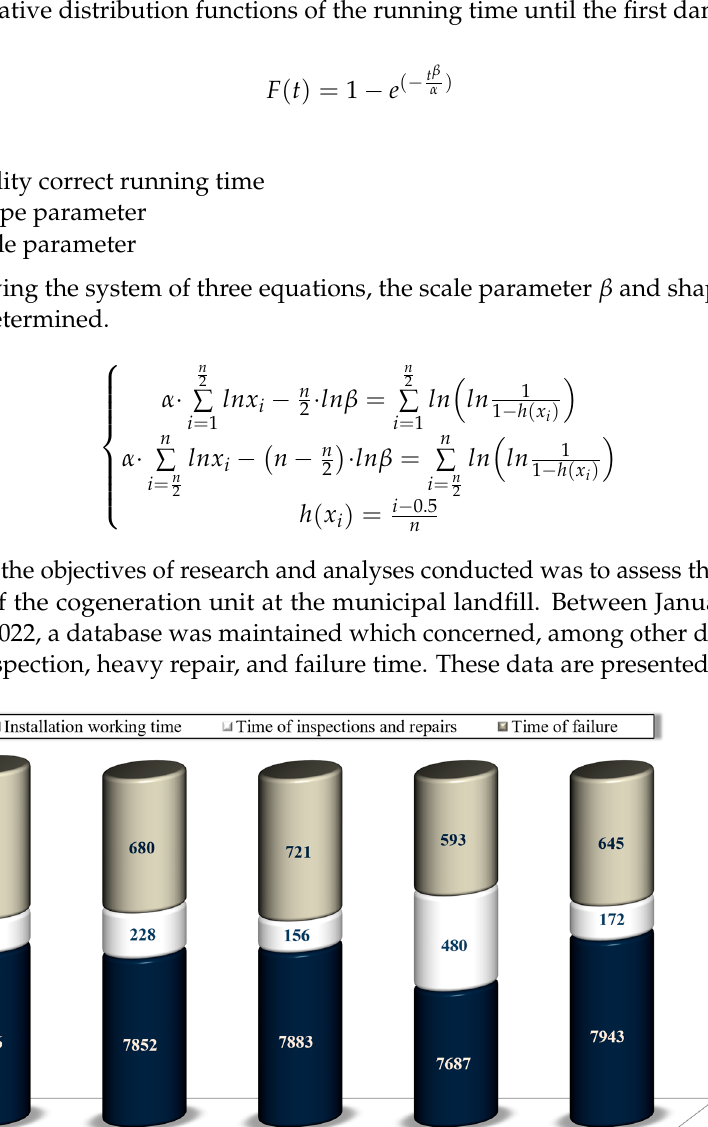
Figure 3. Biogas volume for the generation of electricity and heat in the CHP plant: ( a ) before opti- misation, 2010–2015; ( b ) after the introduction of plant operation management, 2018–2022. The analysis of the data for 2018–2022 showed that the annual average amount of recovered biogas was 1,291,515 m 3 ∙ year − 1 , a figure 29.5% higher than in the previous pe- riod under analysis. This LFG yield enabled the CHP unit to produce 2131.22 MWh of electricity and 2799.44 MWh of heat per year.